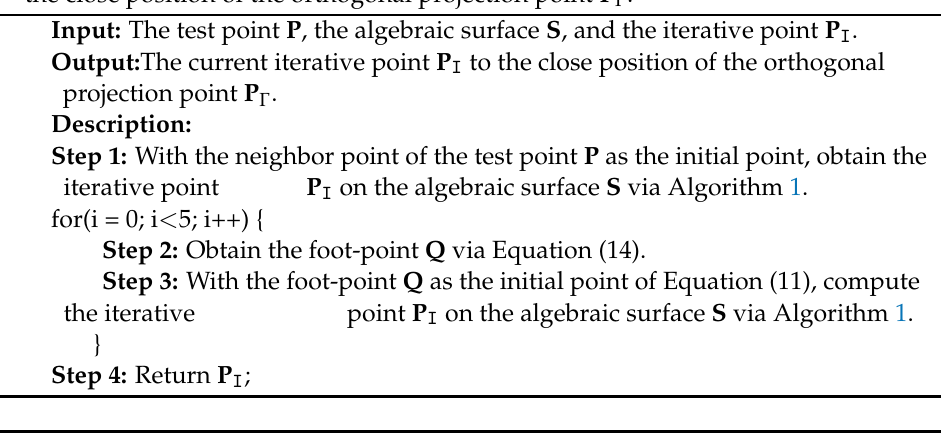
Algorithm 3: Hybrid geometric accelerated orthogonal method.